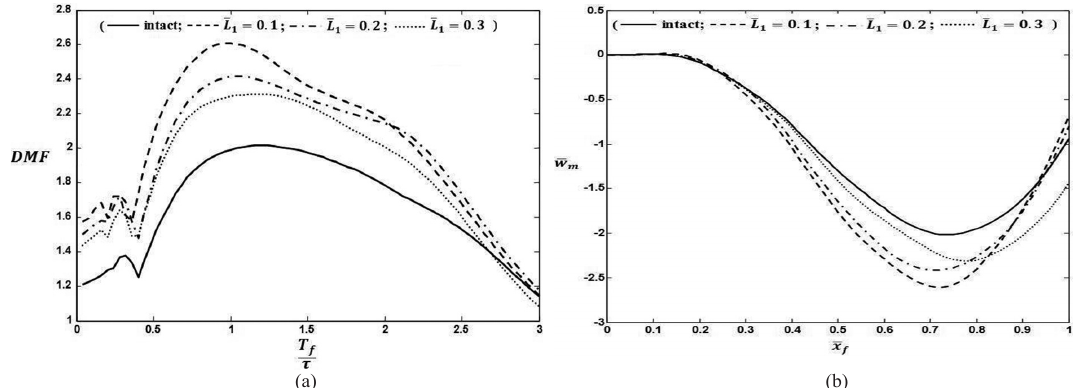
Fig. 6. a) Variation of DMF vs. T for different delamination spanwise location, b) Variation of w m vs. x f for different delamination spanwise location at oscillator critical velocity ( L d = 0 . 4 , located at interface 1)